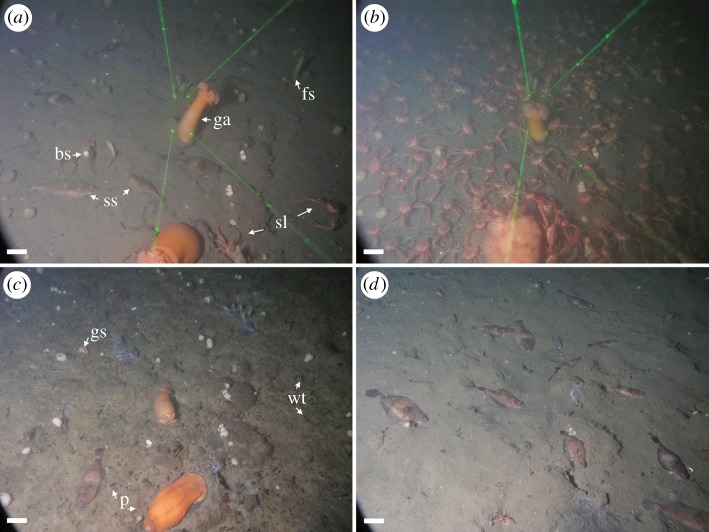
Transitional phases of the epibenthic community in seasonal hypoxia. (a–d) Same field of view from DISCo (pan right, area is 1.4 m2). (a) At the start of the time series (Feb 2012), environmental oxygen concentration ([O2]env) was 1.9 ± 0.2 ml l−1 (mean ± s.d. over 12 h). Slender sole (ss) and squat lobster (sl) were the dominant mobile species. Sessile species included giant anemones (ga), ball sponges (bs), finger sponges (fs) and ascidians. (b) A large squat lobster migration event (adult max density = 123 ind. m−2) occurred at the onset of deoxygenation in Jun 2012 ([O2]env = 1.9 ± 0.3 ml l−1). (c) By Nov 2012, local contributions to beta diversity increased in near-anoxia ([O2]env = 0.05 ± 0.01 ml l−1) with the emergence of macroinfauna such as ghost shrimp (gs), mobile epifaunal polychaetes (p) and those that built worm tubes (wt). Slender sole and sessile species were present in reduced numbers. (d) After reoxygenation (Feb 2013, [O2]env = 0.6 ± 0.3 ml l−1), slender sole abundance increased, macroinfauna disappeared, but sessile species abundance decreased due to the hypoxia-induced mortality of the sponges, ascidians and the two giant anemones. Scale bars = 10 cm.